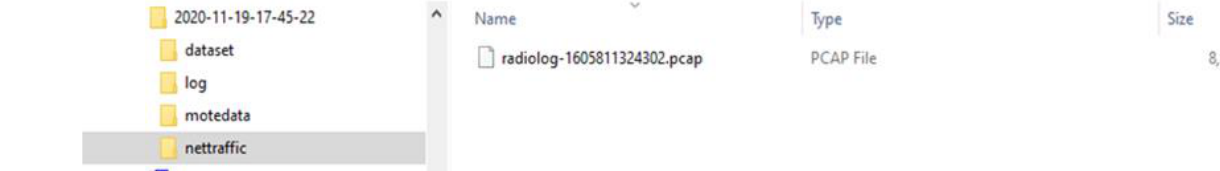
Figure 16. The “nettraffic” folder inside the root folder “2020 -11-19-17-45- 22” and the copy of the “radiolog -